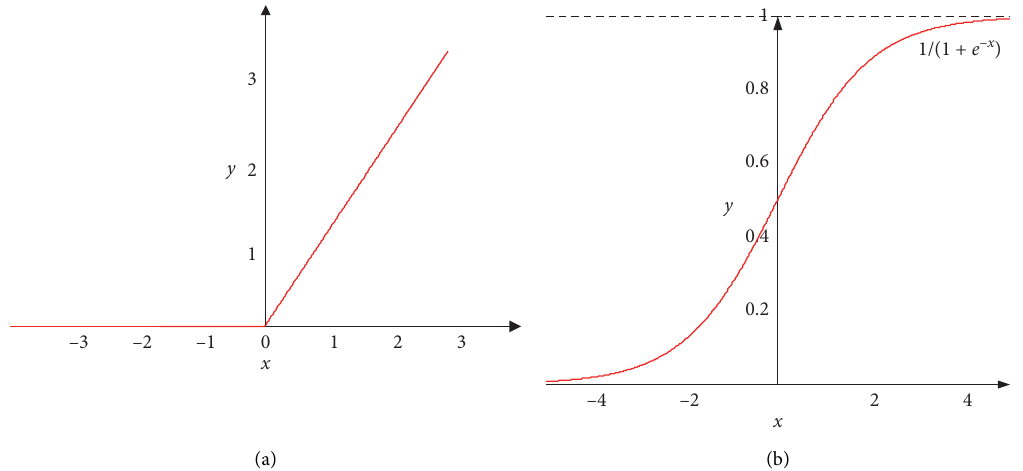
Figure 2: Activation function. (a) ReLU function image. (b) Sigmoid function image.